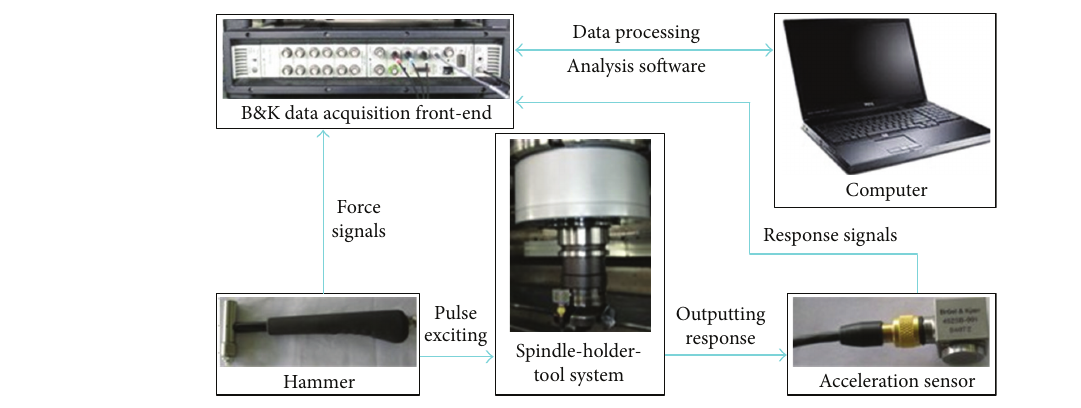
Figure 9: The test system.